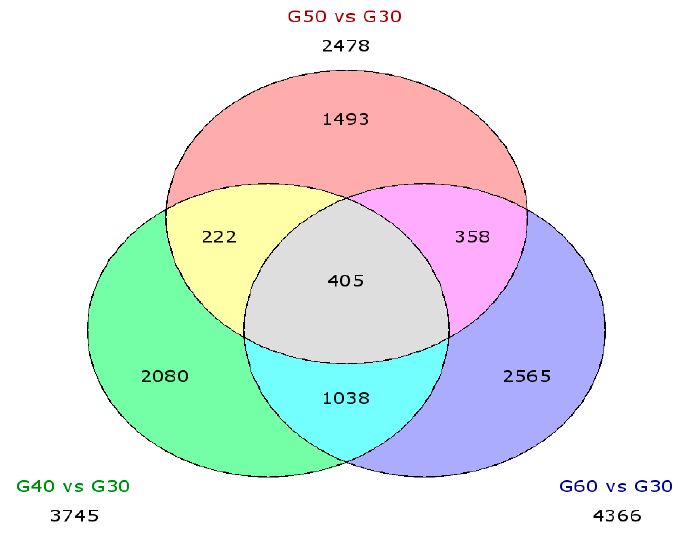
Figure 5. Venn diagram showed a significant overlap of differential expression genes in the pair- wise